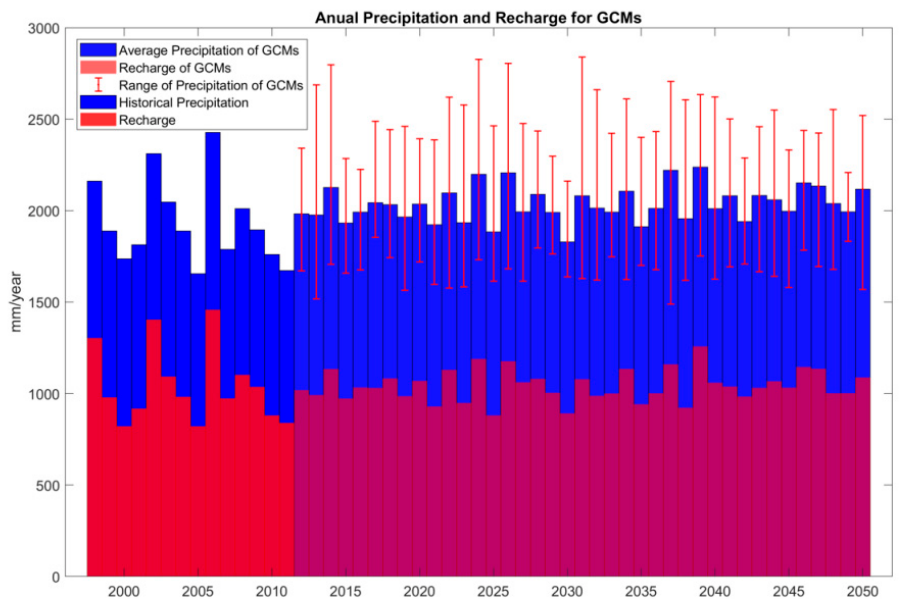
Figure 6. Bar plot showing annual historical precipitation, future estimated precipitation from general circulation models (GCMs), and estimated historical and future annual recharge. The blue bars represent annual rainfall depths (mm / year), and the red bars represent annual recharge depths (mm / year). The future rainfall values are the average of the selected GCMs, with error bars to quantify the spread of the GCMs.